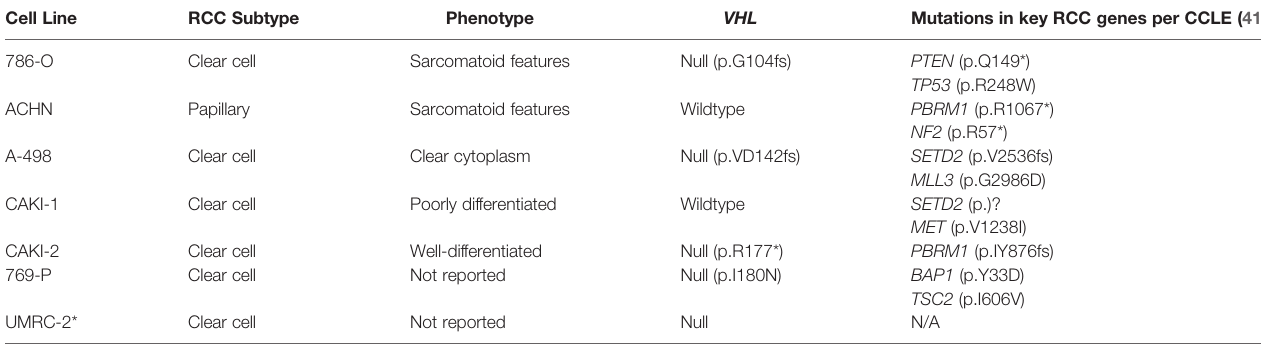
TABLE 1 | Common renal cell carcinoma cell lines (36, 40,